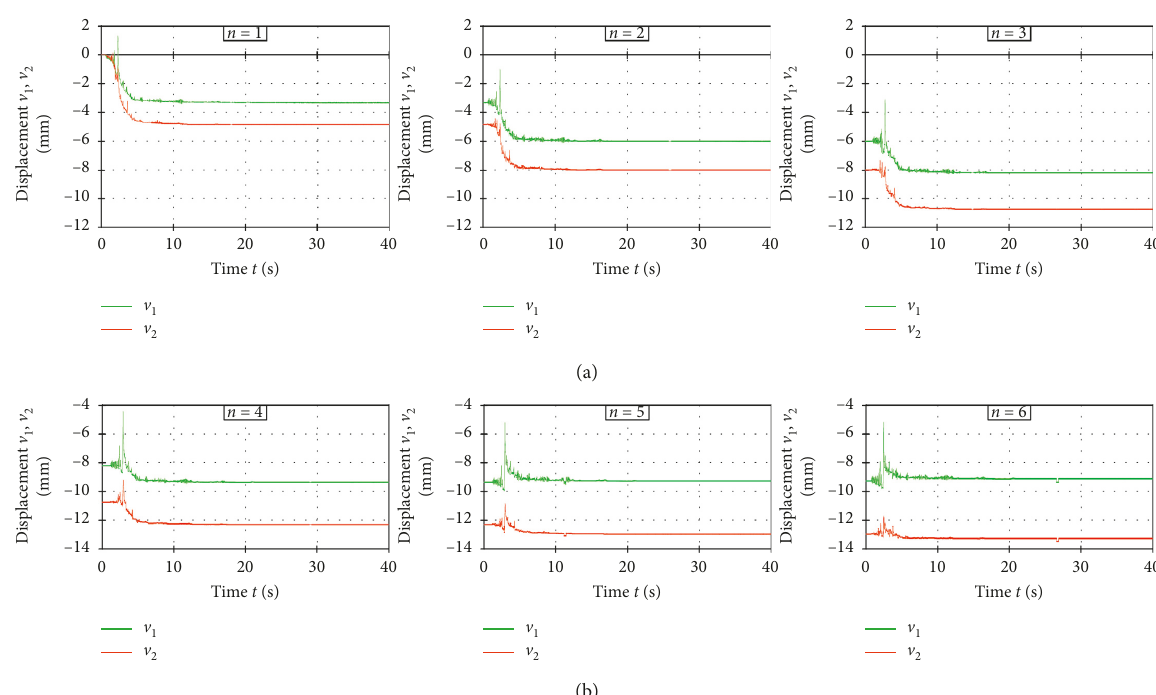
Figure 32: Vertical displacements v